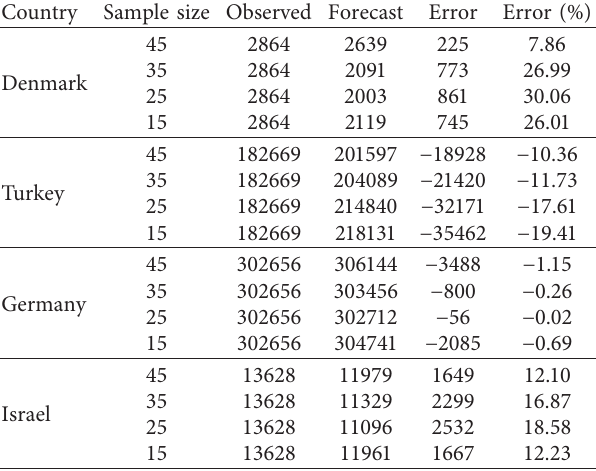
Table 6: The forecast error of the best-fit models for year